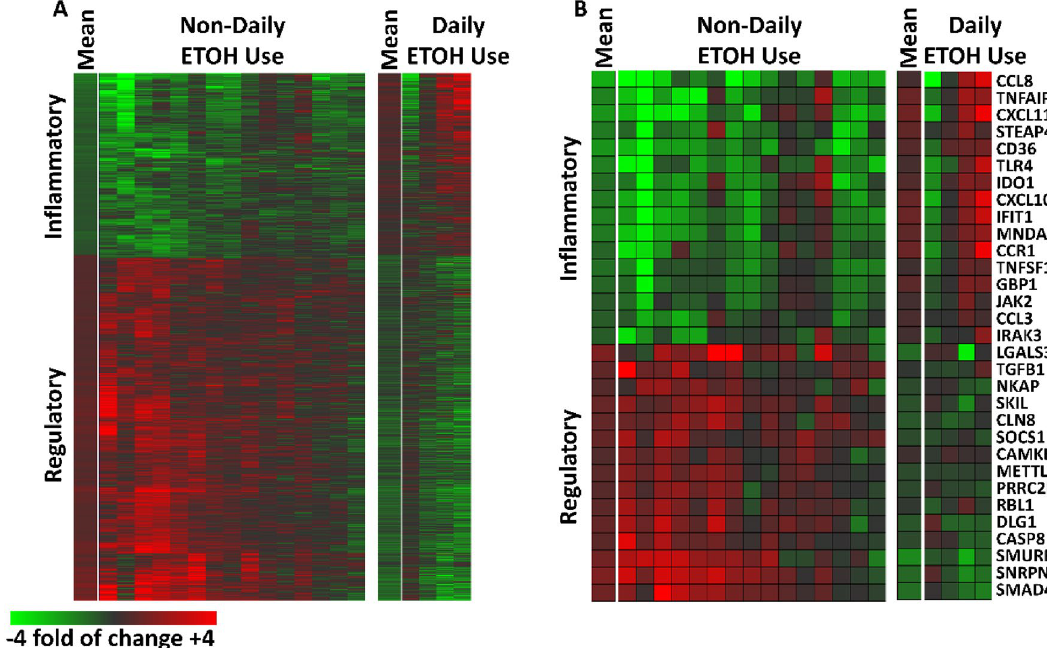
Figure 2. Post-Lp299v Plasma-Induced PBMC Signatures ‒ Stratified by Daily and Non-Daily Alcohol Drinkers: ( A ) 1,443 probe sets representing 997 unique genes were altered by at least 20% with a qval FDR < 0.2) in 15 individuals with stable CAD who did not report daily alcohol use (left) and four individuals with stable CAD who did report daily alcohol use (right). The mean for each group is indicated and each subsequent column is a subject. Data are expressed as a fold of change post- vs pre-supplementation with Lp299v . Red represents upregulated probe sets (n = 505); green represents downregulated probe sets (n = 938). ( B ) Well annotated transcripts associated with inflammatory and regulatory activity that showed significant change with Lp299v supplementation in these subjects.